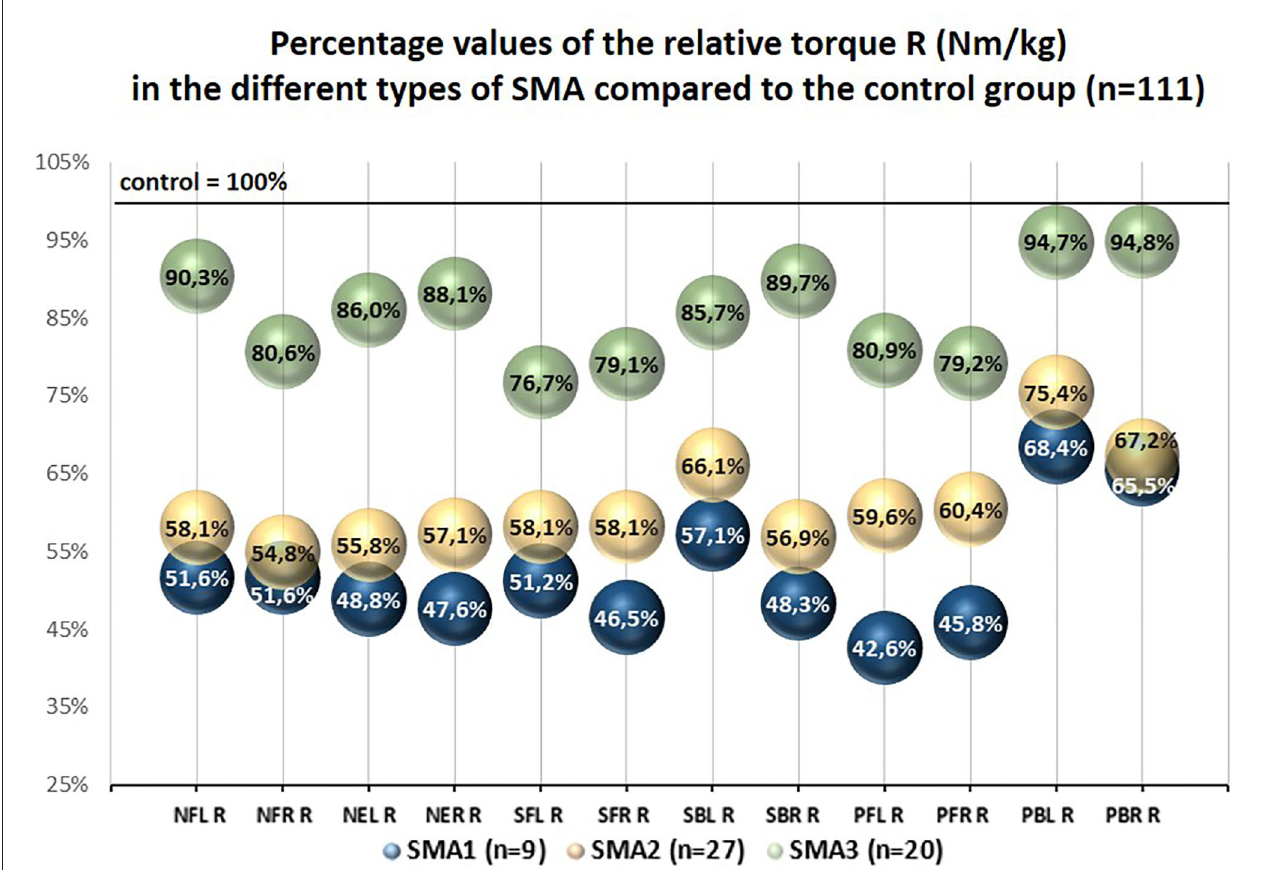
FIGURE 3 | Percentage values of the relative torque R (Nm/kg) in the different types of SMA compared to the control group ( n =